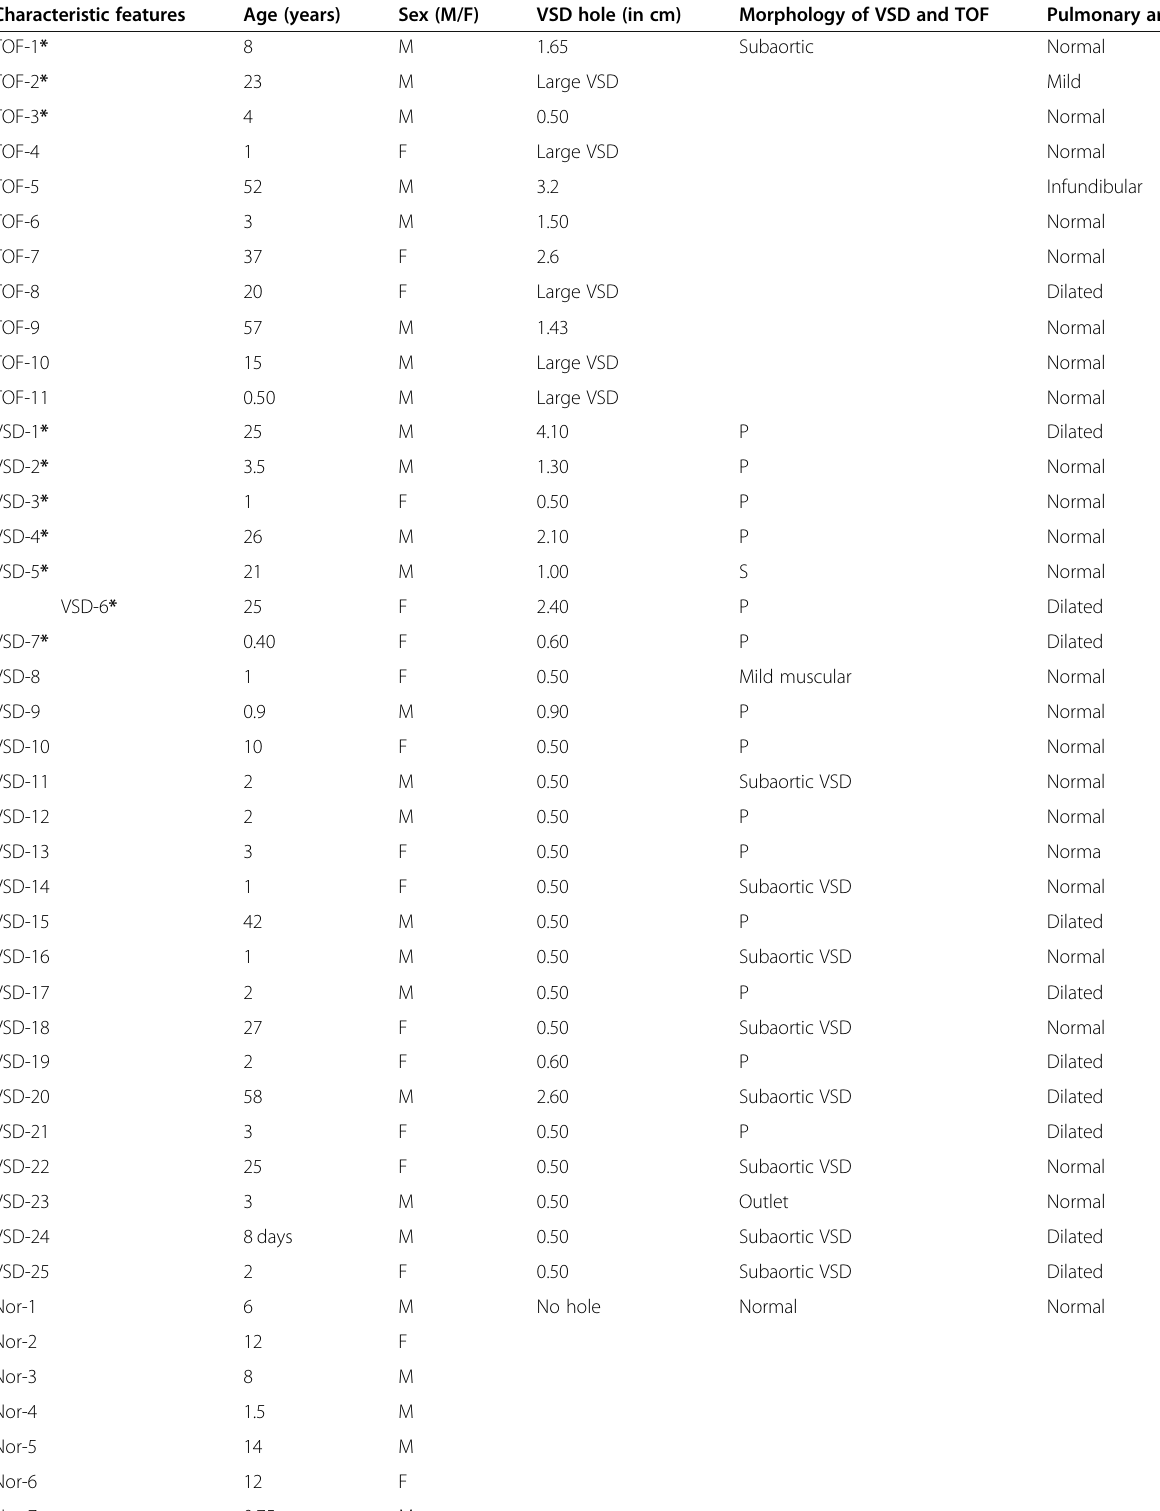
Table 1 Details of clinical and diagnostic analysis for TOF and VSD samples used for whole-exome sequencing (*) and validation (without asterisk) Characteristic